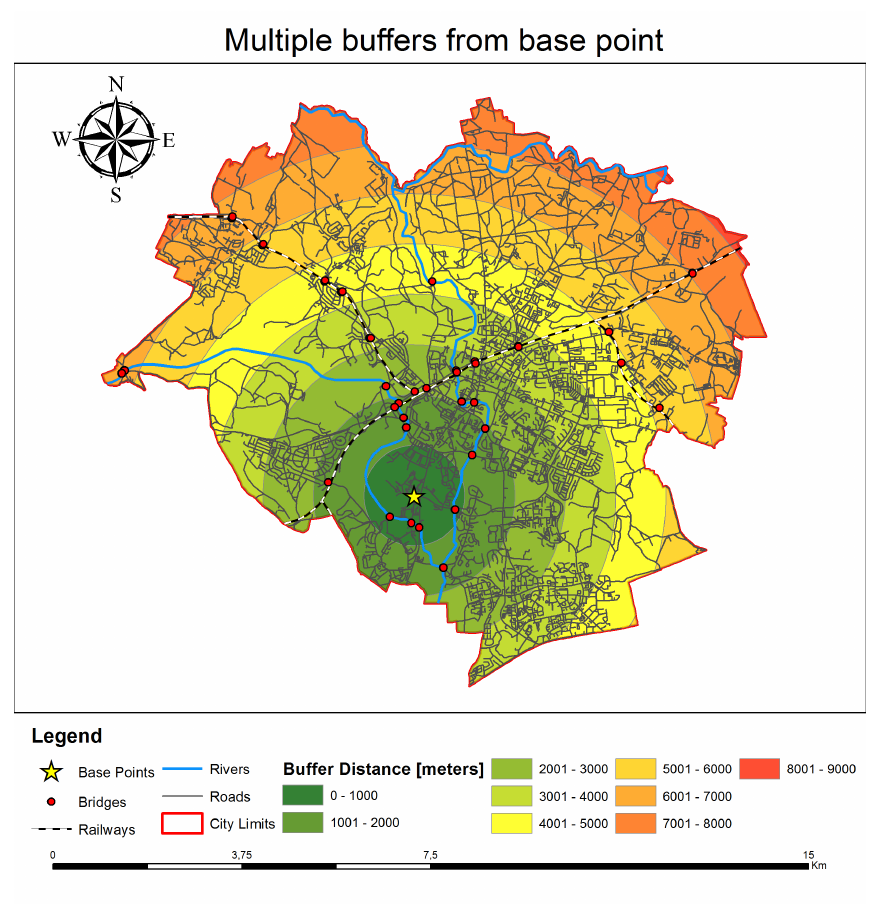
Figure 17. Service areas identified with the use of buffers based on Euclidean